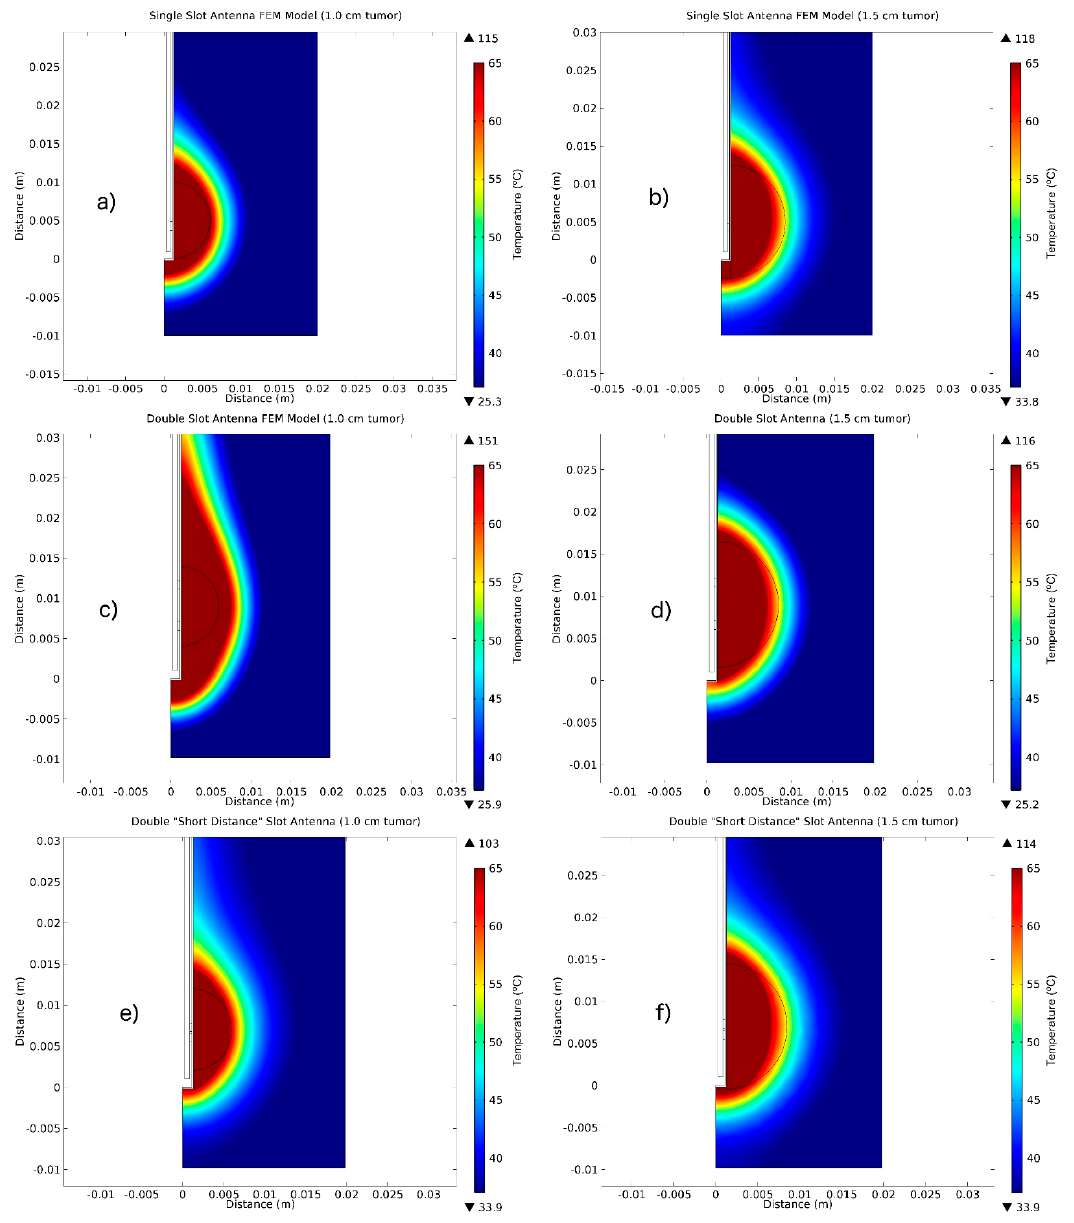
Figure 3. Thermal distributions obtained over tumor tissue surrounded by healthy breast tissue generated by the 2D axisymmetric FEM model. ( a ) Single slot antenna inserted in a 1.0 cm diameter tumor, ( b ) Single slot antenna inserted in a 1.5 cm diameter tumor phantom, ( c ) Double slot antenna inserted in a 1.0 cm diameter tumor, ( d ) Double slot antenna inserted in a 1.5 cm diameter